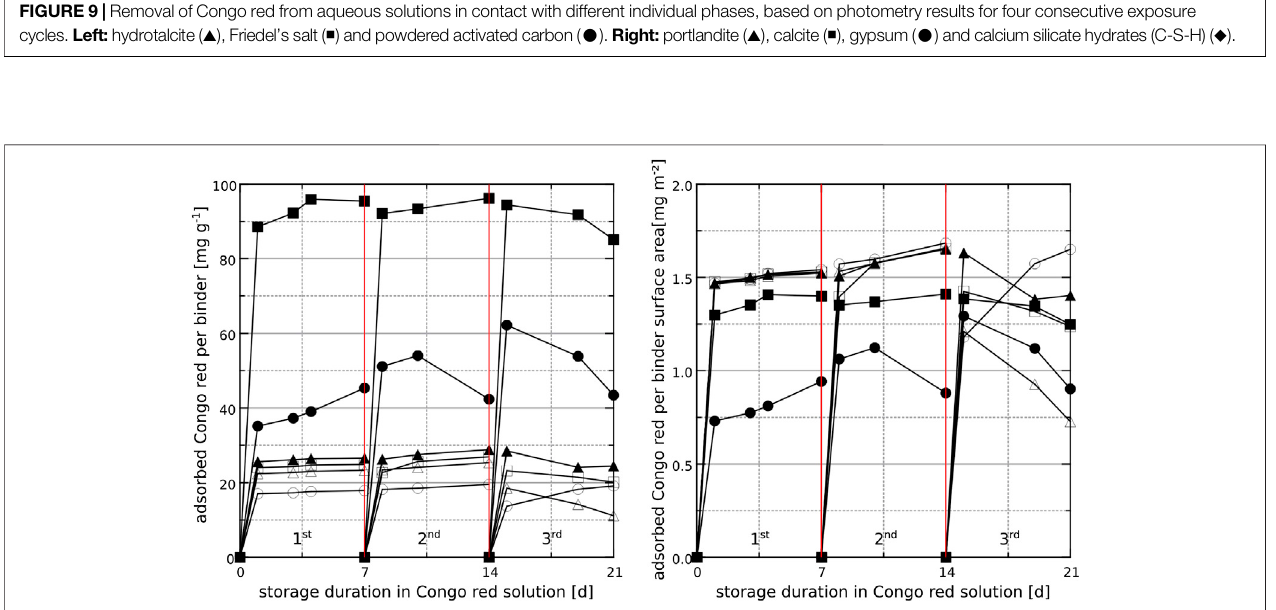
FIGURE 10 | Removal of Congo red from aqueous solutions in contact with hardened binder paste surfaces (powder of 200 µm surface layer), based on photometryresultsforthreeconsecutiveexposurecycles. Left: removedCongoredpermassofhardenedbinderpaste. Right: removedCongoredperspeci fi csurface areaofhardenedcementpaste.18_SO4( ▲ ),65_SO4( ■ )and80_SO4( C ).Theopensymbolsareforsampleswiththesamebindercomposition,butwhichwerestored in saturated calcium hydroxide solution before the dye exposure